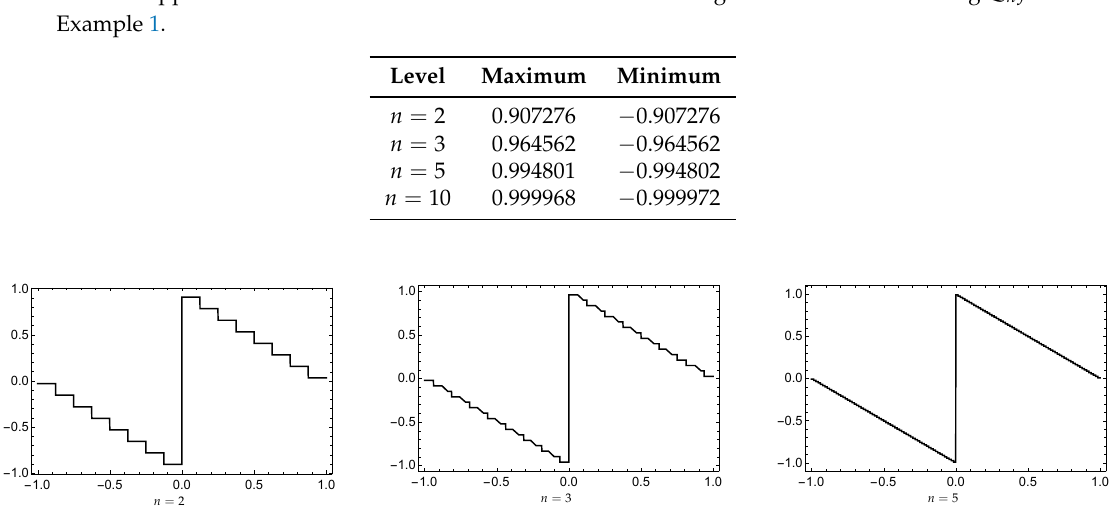
Figure 7. Illustration for the absence of the Gibbs effect using the quasi-operator Q n f of Example 1.